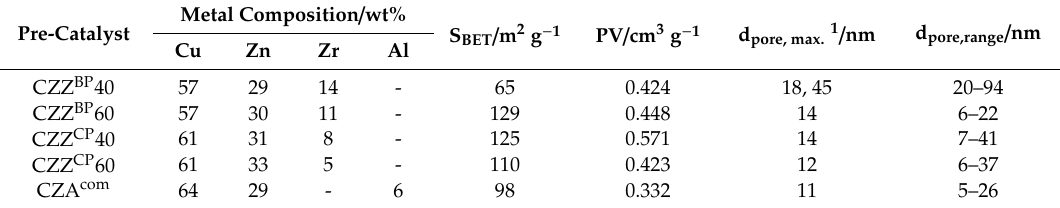
Table 1. Chemical composition, specific surface area (S BET ), pore volume (PV) and the maxima and ranges of the pore size distribution (d pore ) of the metal oxide pre-catalysts (Cu:Zn:Zr ratio in the precursor solution was 57:29:14